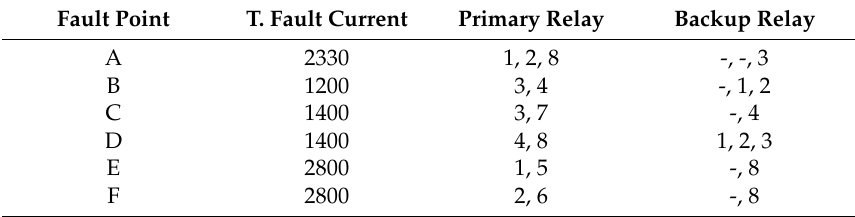
Figure 5. A multi-loop distribution system. Table 1. Total fault current and primary/backup relationships of relays for Case 1.